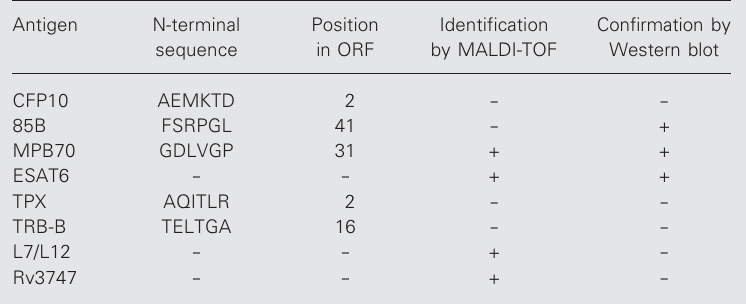
Table 2. Identification of Mycobacterium bovis in antigenic fractions.